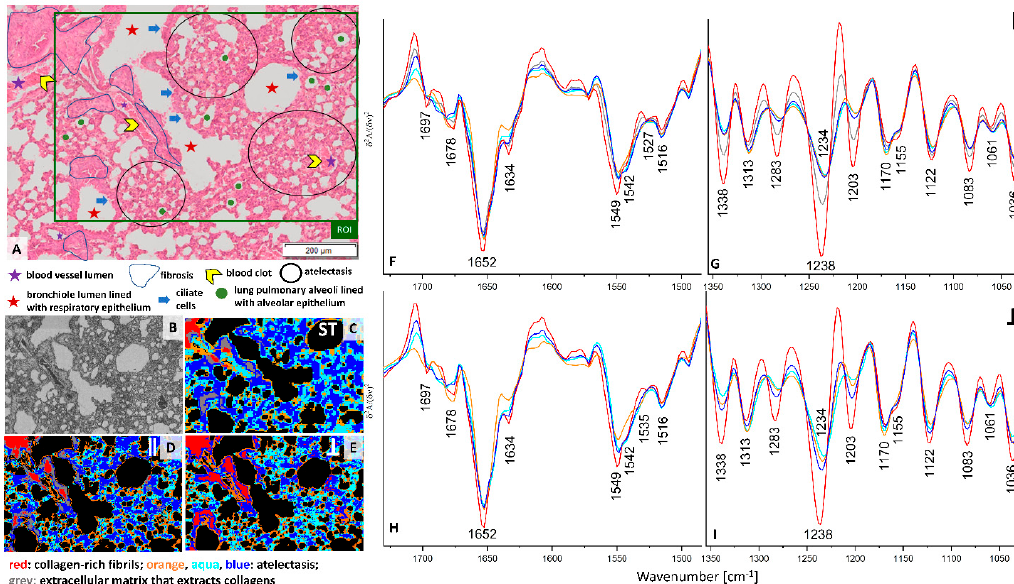
Figure 2. ( A ) A H&E micro ‐ photography (20×) showing cellular phenotypes of lung parenchyma in the pre ‐ metastatic phase (week 2) and ROI (green area) imaged spectroscopically (magnification: 20×); ( B ) a white ‐ field image of the ROI (magnification: 15×); false ‐ colour UHCA maps for IR images recorded by using non ‐ polarized FTIR imaging ( C ), 0° ( D ) and 90° ( E ) polarization contrast imaging. Mean second derivative FTIR spectra extracted from UHCA maps for 0° ( F , G ) and 90° ( H , I ) polarized IR. Mean spectra of non ‐ polarized FTIR imaging are collected in Figure S3G,H. The colors of classes correspond to the colors of spectra.